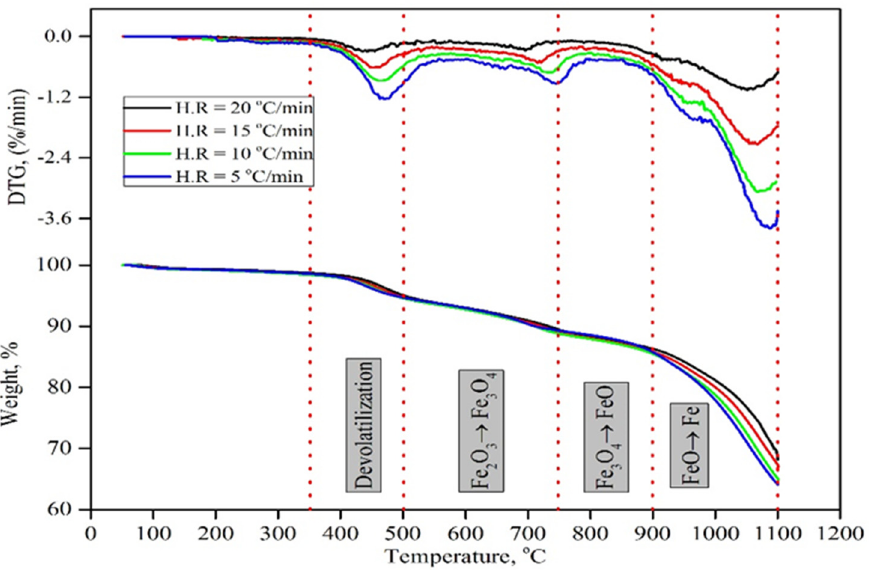
Figure 6. Influence of reduction temperature on the TG and DTG of the iron ore fines-coal composites using different heating rates (H.R).